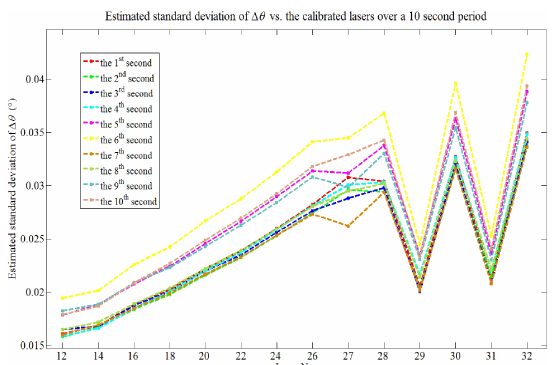
Figure 16. The standard deviations of the estimated Δ θ by the calibration on Dataset 2 over a 10 second